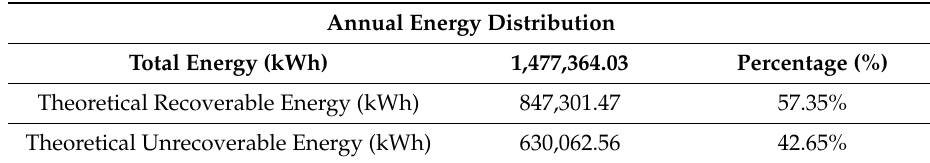
Table 7. Annual energy distribution from point #7. Table 8. Highlights from energy balance at point #7 for each scenario.